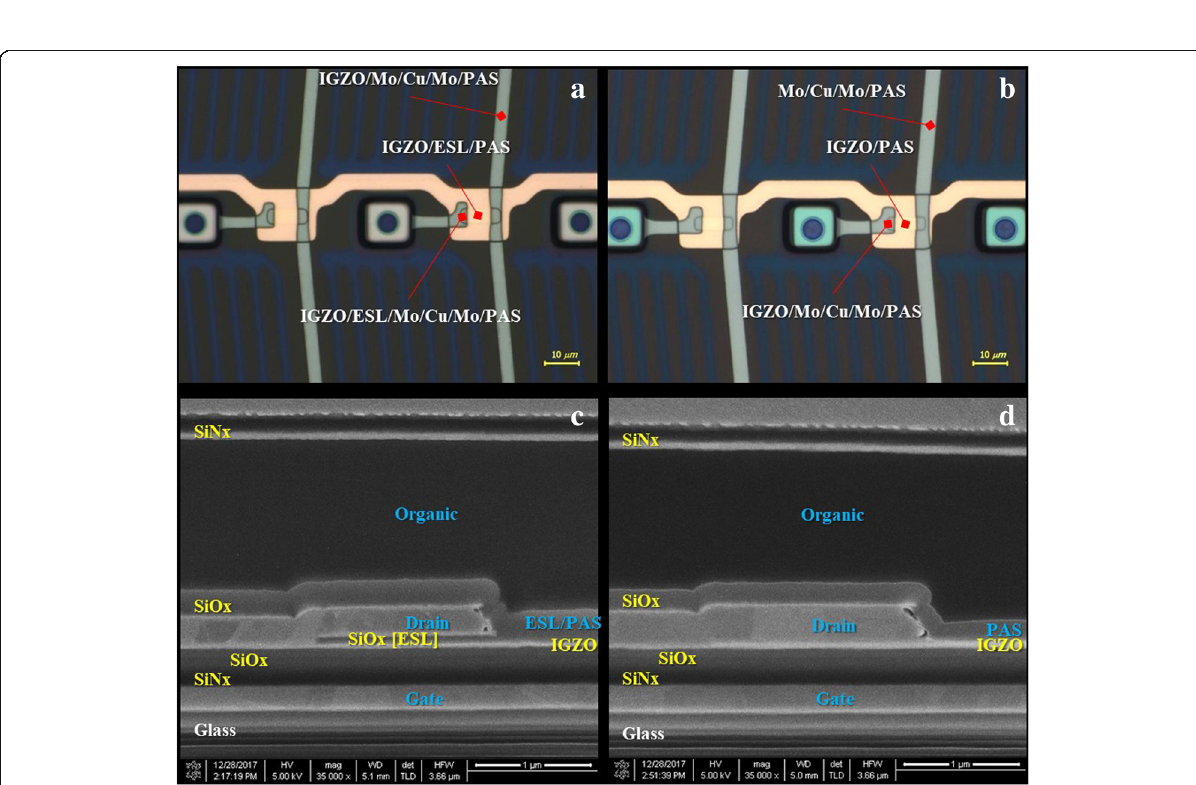
Fig. 3 SEM images of the a-IGZO TFTs: a CL-ES-structured TFT top view, b BCE-structured TFT top view, c CL-ES-structured TFT cross-sectional view, and d BCE-structured TFT cross-sectional